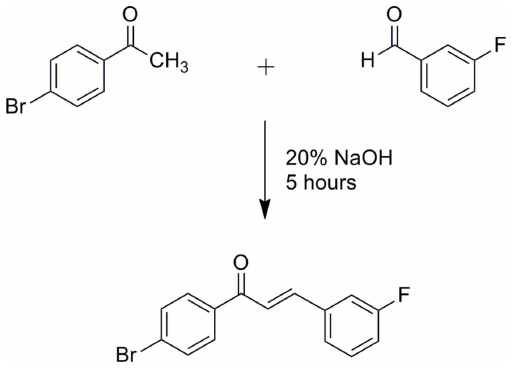
[Table 1, Fig. 2( b )] hydrogen bonds also connect the A mol-